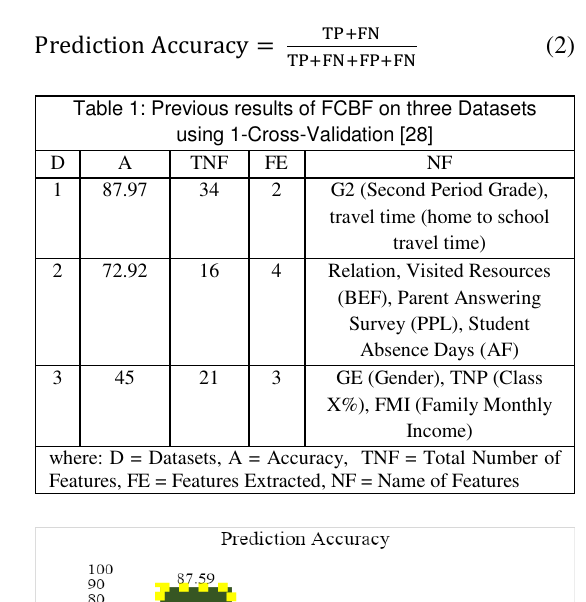
Table 1: Previous results of FCBF on three Datasets